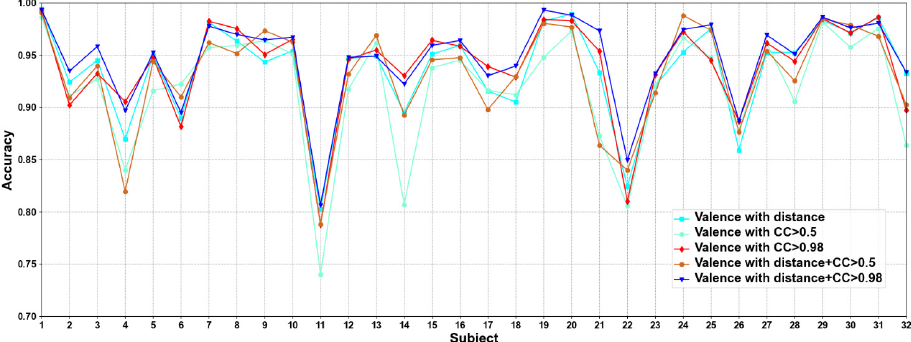
Figure 5. Classification accuracies on each subject on valence under construction of different adja- cency matrices.